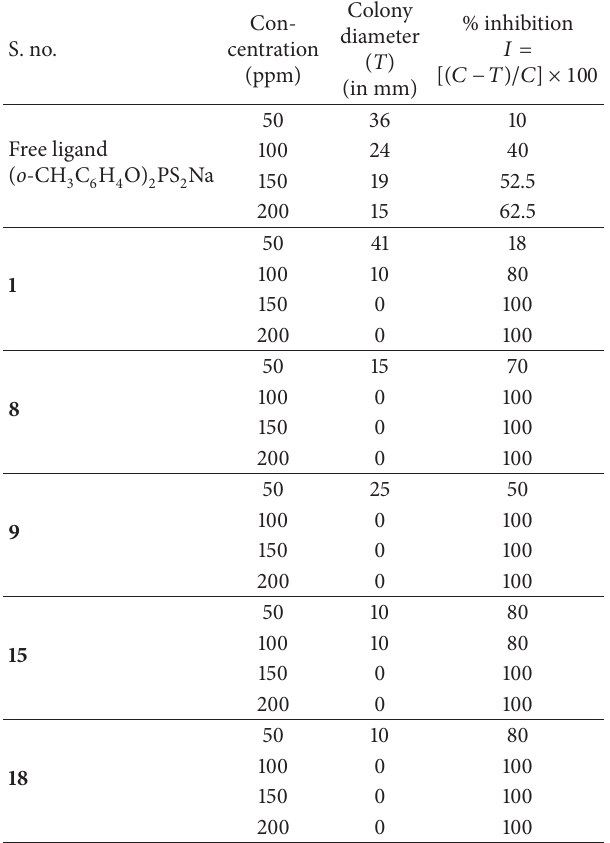
Mean colony diameter of control (C) = 50mm.